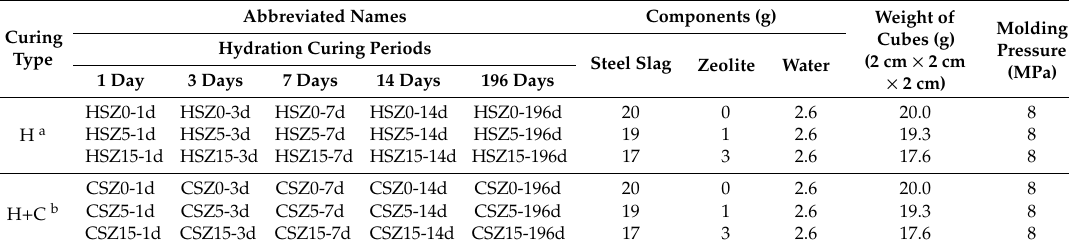
Table 3. Components of the mix proportions of slag partially substituted by zeolite (SZ) specimens.